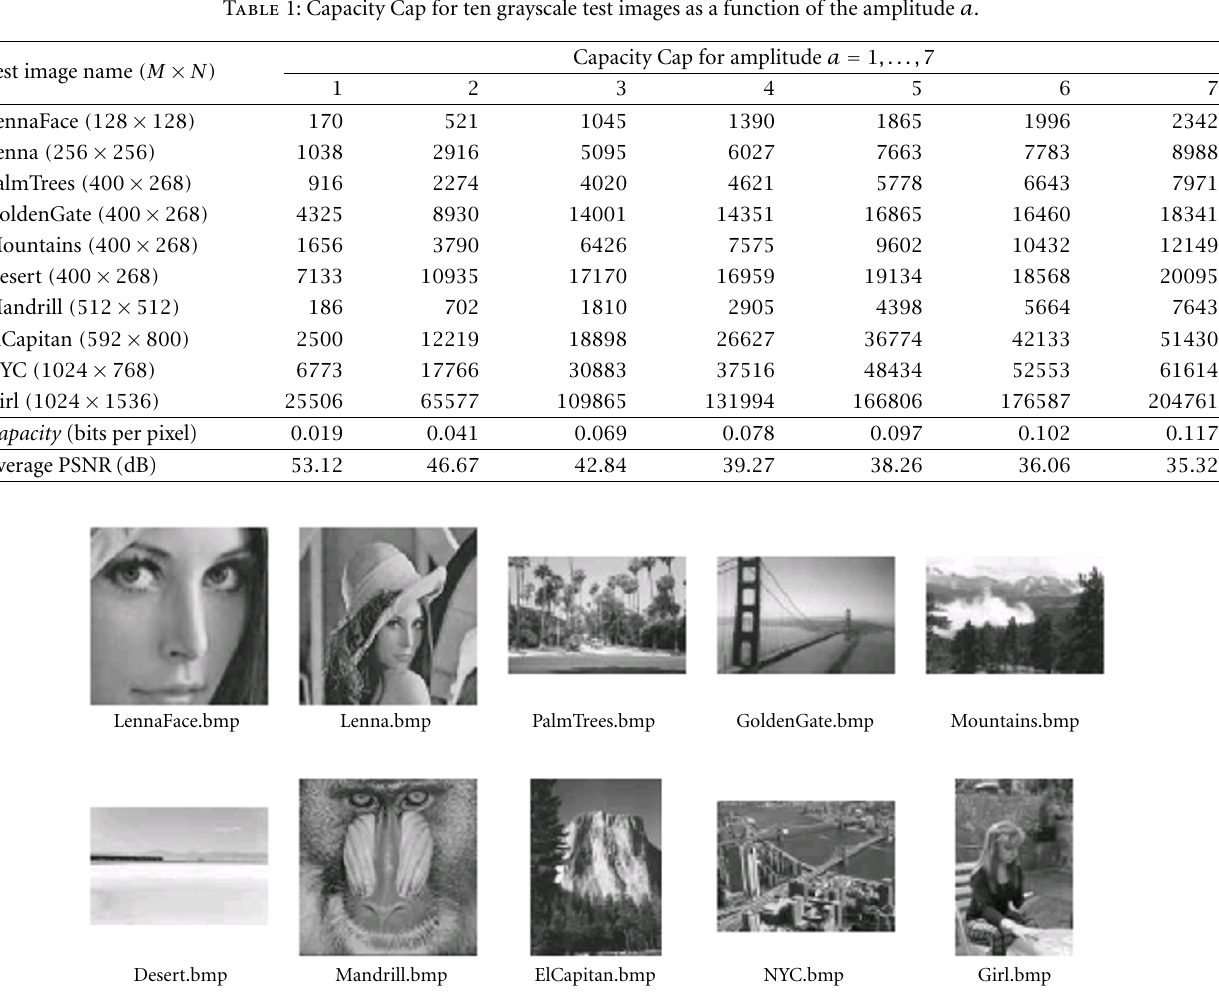
Figure 3: Test images used in Table